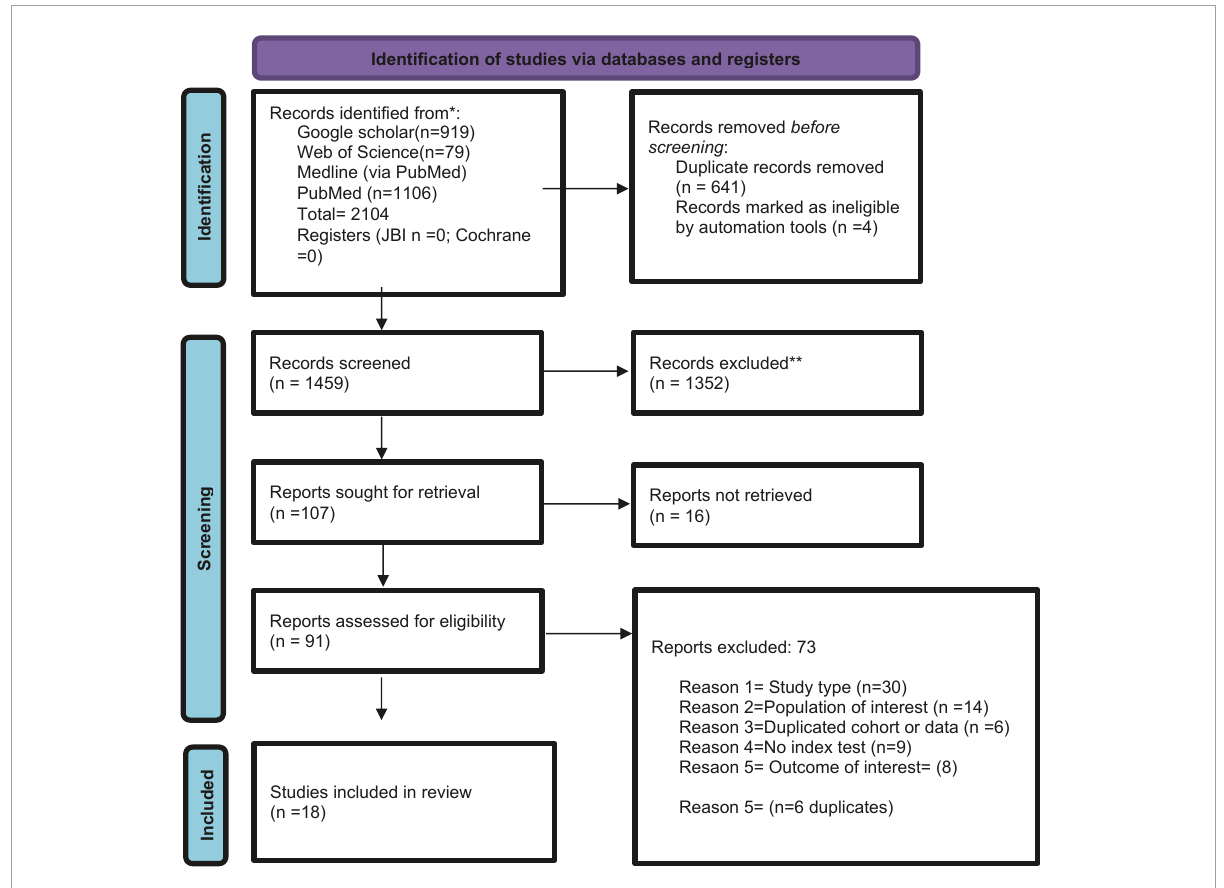
FIGURE1 Flowchart summarizing inclusion in systematic review of studies. *Consider, if feasible to do so, reporting the number of records identified from each database or register searched (rather than the total number across all databases/registers). **If automation tools were used, indicate how many records were excluded by a human and how many were excluded by automation tools. From: Page MJ, McKenzie JE, Bossuyt PM, Boutron I, Hoffmann TC, Mulrow CD, et al. The PRISMA 2020 statement: an updated guideline for reporting systematic reviews. BMJ 2021;372:n71. doi: 10.1136/bmj.n71. For more information, visit: